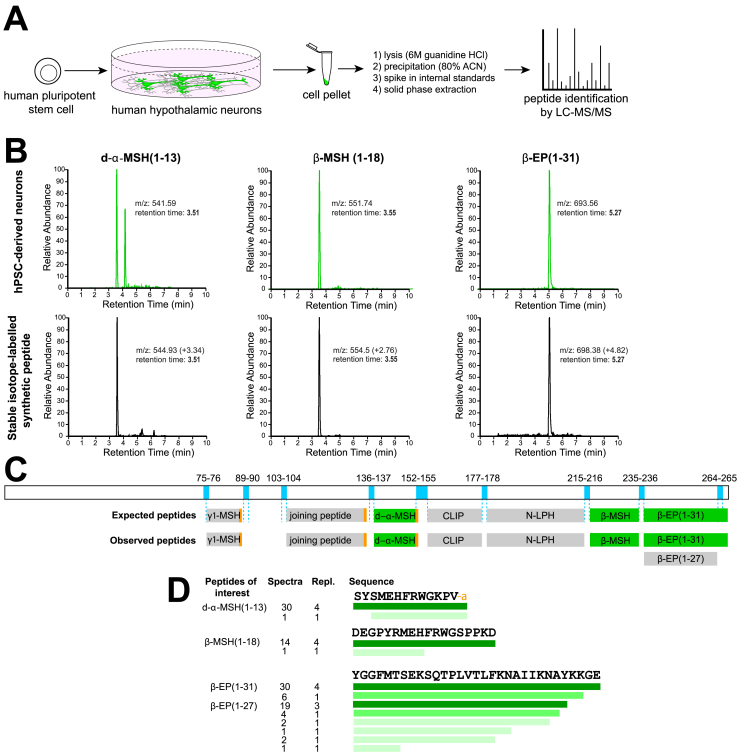
Identification of processed POMC peptides by LC-MS/MS. A) Schematic workflow for the quantification of POMC-derived peptides from hPSC-derived hypothalamic neurons. B) Liquid chromatographs of samples from hPSC-derived hypothalamic neurons (top), compared with stable isotope-labelled synthetic d-α-MSH(1-13), β-MSH(1-18) and β-EP (1-31) (bottom). Note that heavy isotope-labelled reference peptides have identical retention times as endogenous peptides but have slightly higher mass-to-charge (m/z) ratios, and that m/z values measured from Orbitrap and triple quadrupole mass spectrometers may differ. C) Schematic of human POMC protein and relevant dibasic cleavage sites (blue), expected POMC-derived peptides, and those peptides detected in hPSC-derived hypothalamic cultures by LC-MS/MS. Detected peptides included γ1-MSH (Lys- γ1-MSH), d-α-MSH(1-13), β-MSH(1-18) and β-EP (1-31). Quantified peptides are indicated in green. D) Summary of POMC-derived peptides detected by LC-MS/MS, where the colour intensity represents the relative abundance of each peptide species. Repl., replicates. Other abbreviations are as in Figure 1.